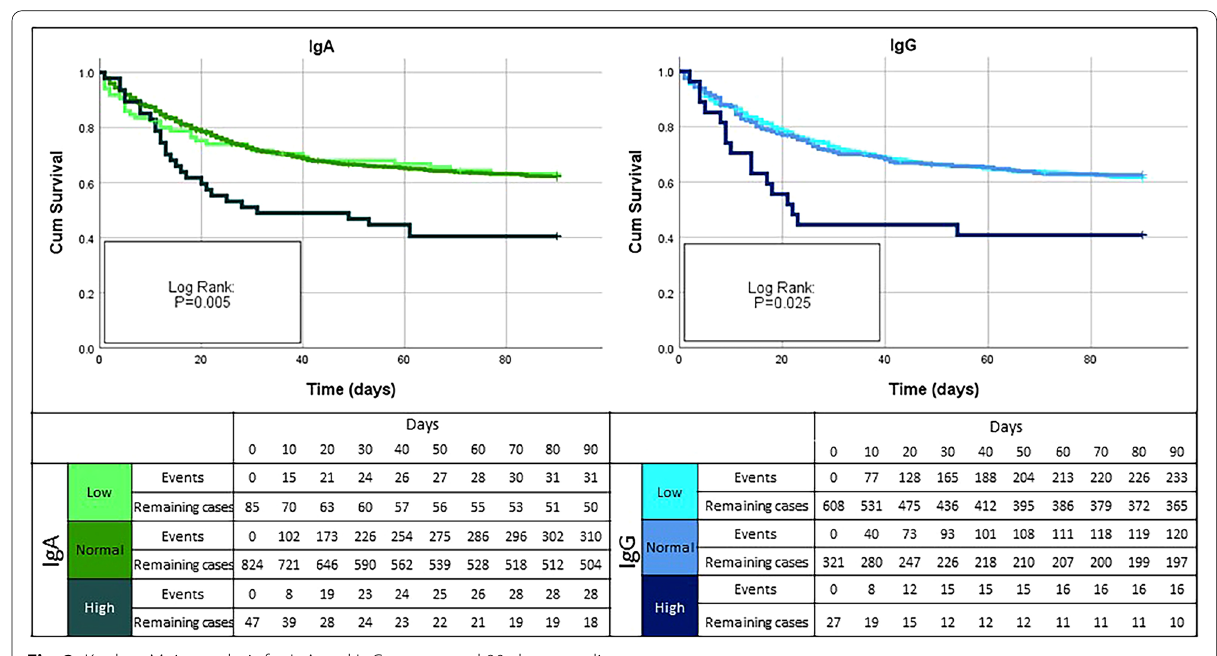
Table 2 Cox regression analysis for 28- and 90-day survival